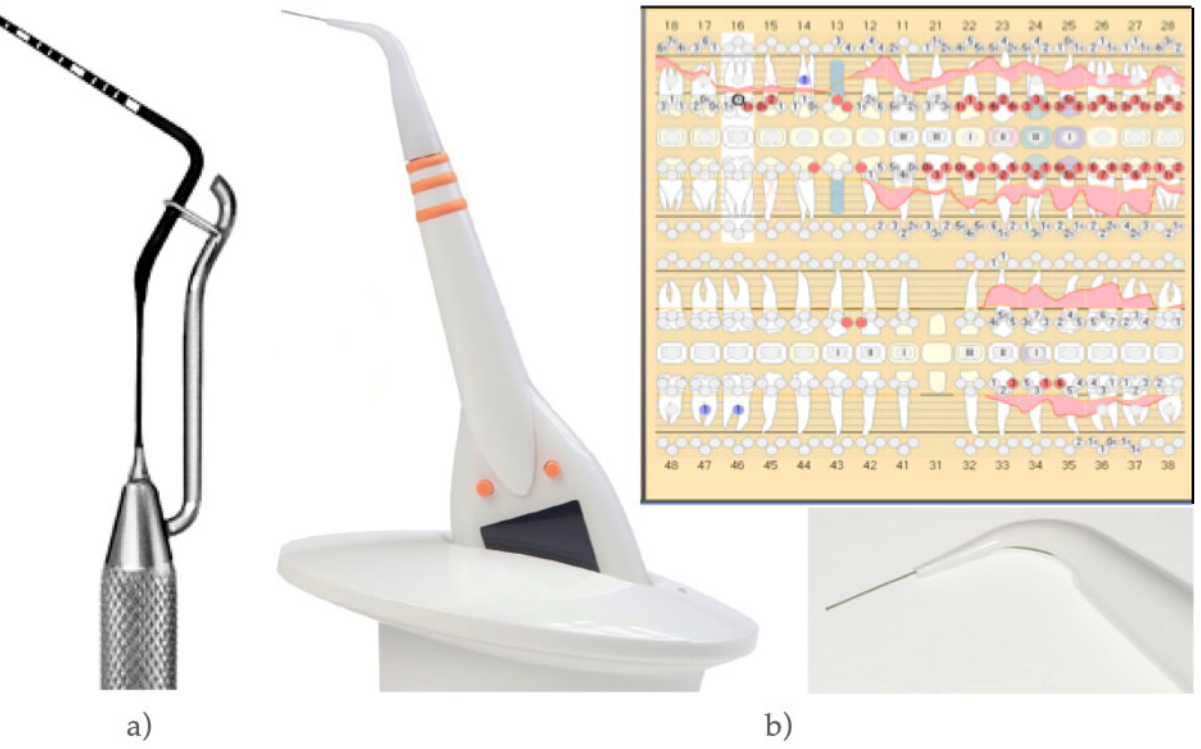
Figure 1. ( a ) Pressure calibrated manual probe (MP); ( b ) Electronic probe (EP), magnification of its disposable tip and periodontal chart (automatically generated).